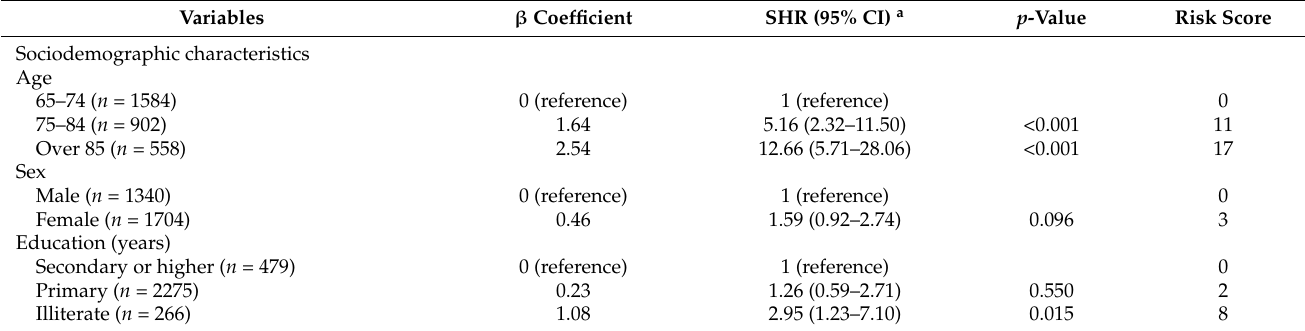
Table 2. Risk factor associations with AD risk in a multivariate regression